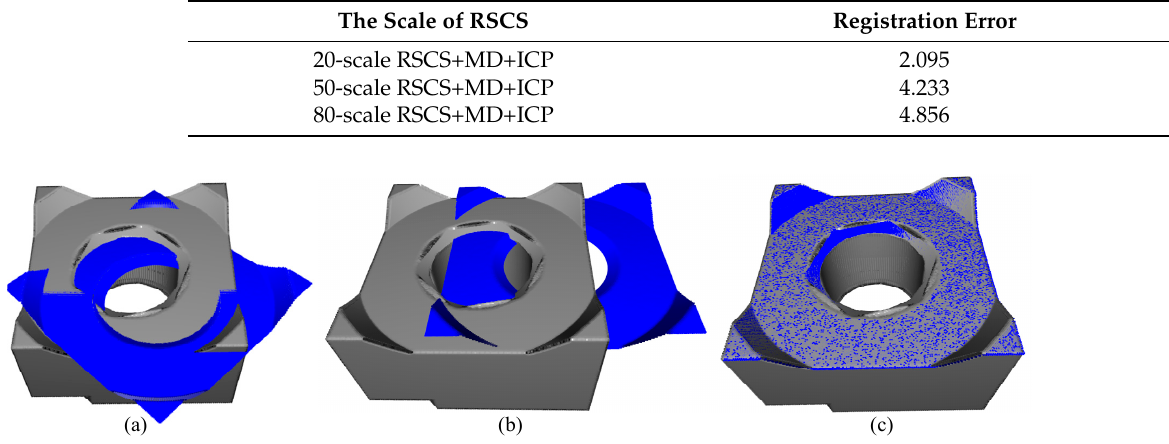
Table 1. Influence of RSCS at different scales on parts registration error (mm).